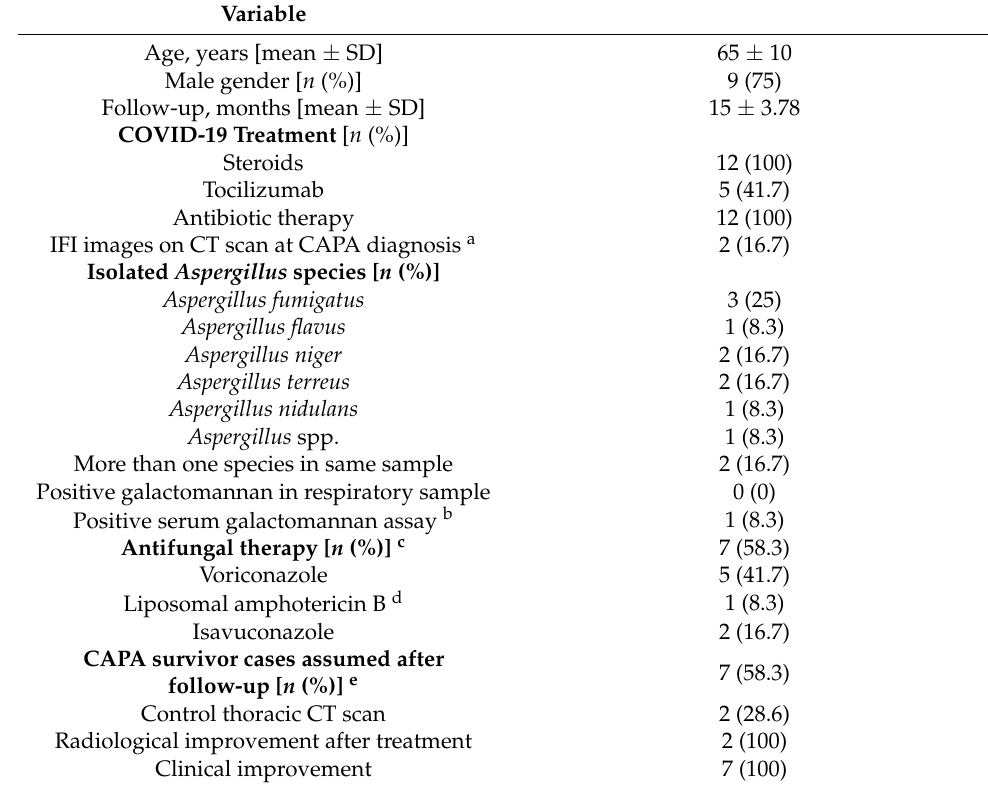
Table 2. Follow-up of patients classified as CAPA ( n =